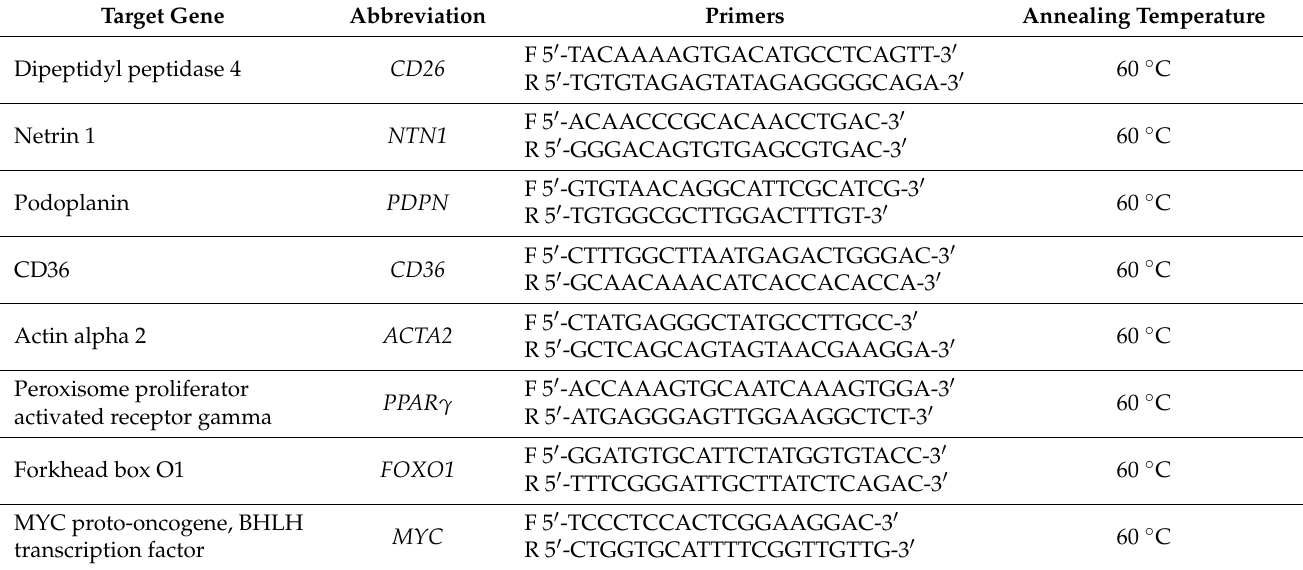
Table 1. PCR primers and annealing temperature for dexamethasone- and dermis-related